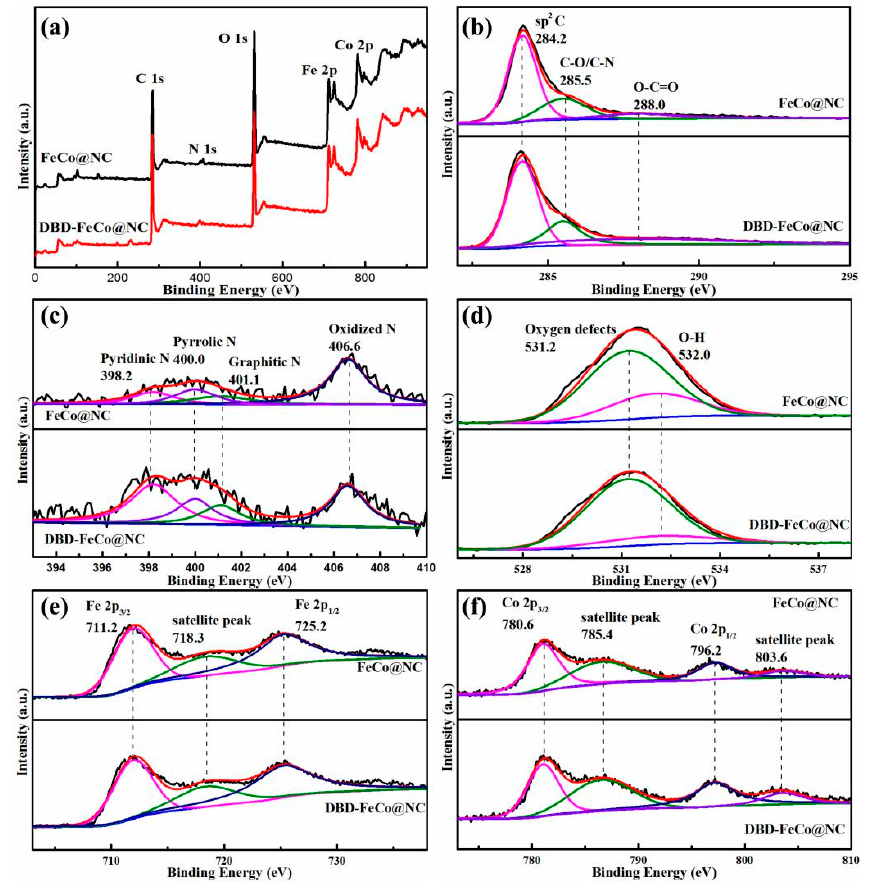
Figure 2. ( a ) XPS spectrum, ( b ) C 1s spectra, ( c ) N 1s spectra, ( d ) O 1s spectra, ( e ) Fe 2p spectra, ( f ) Co 2p spectra of FeCo@NC, and DBD-FeCo@NC. Table 1. Atomic content of FeCo@NC and DBD-FeCo@NC.